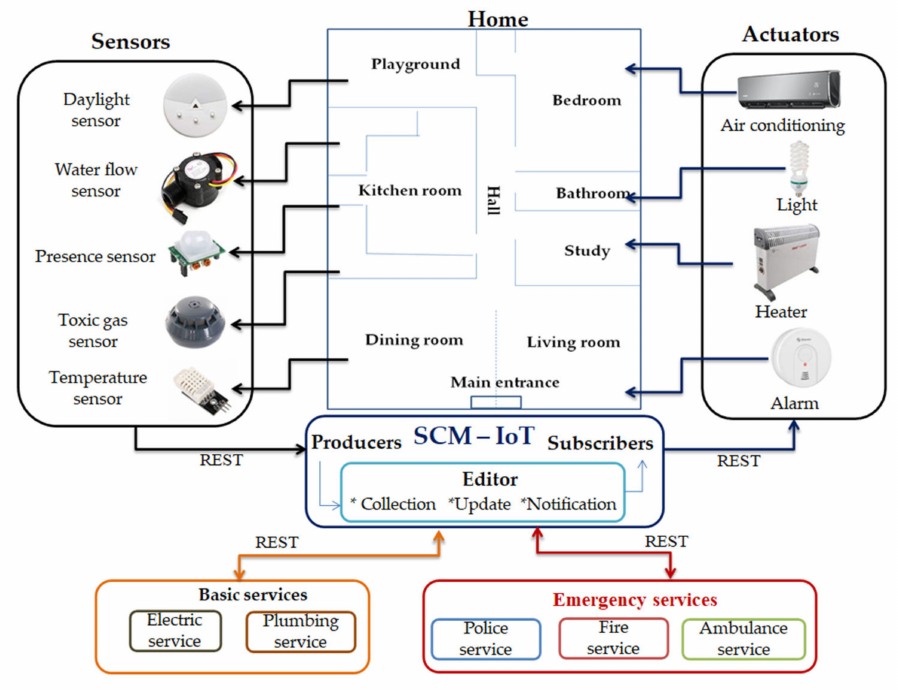
Figure 1. SCM-IoT deployment